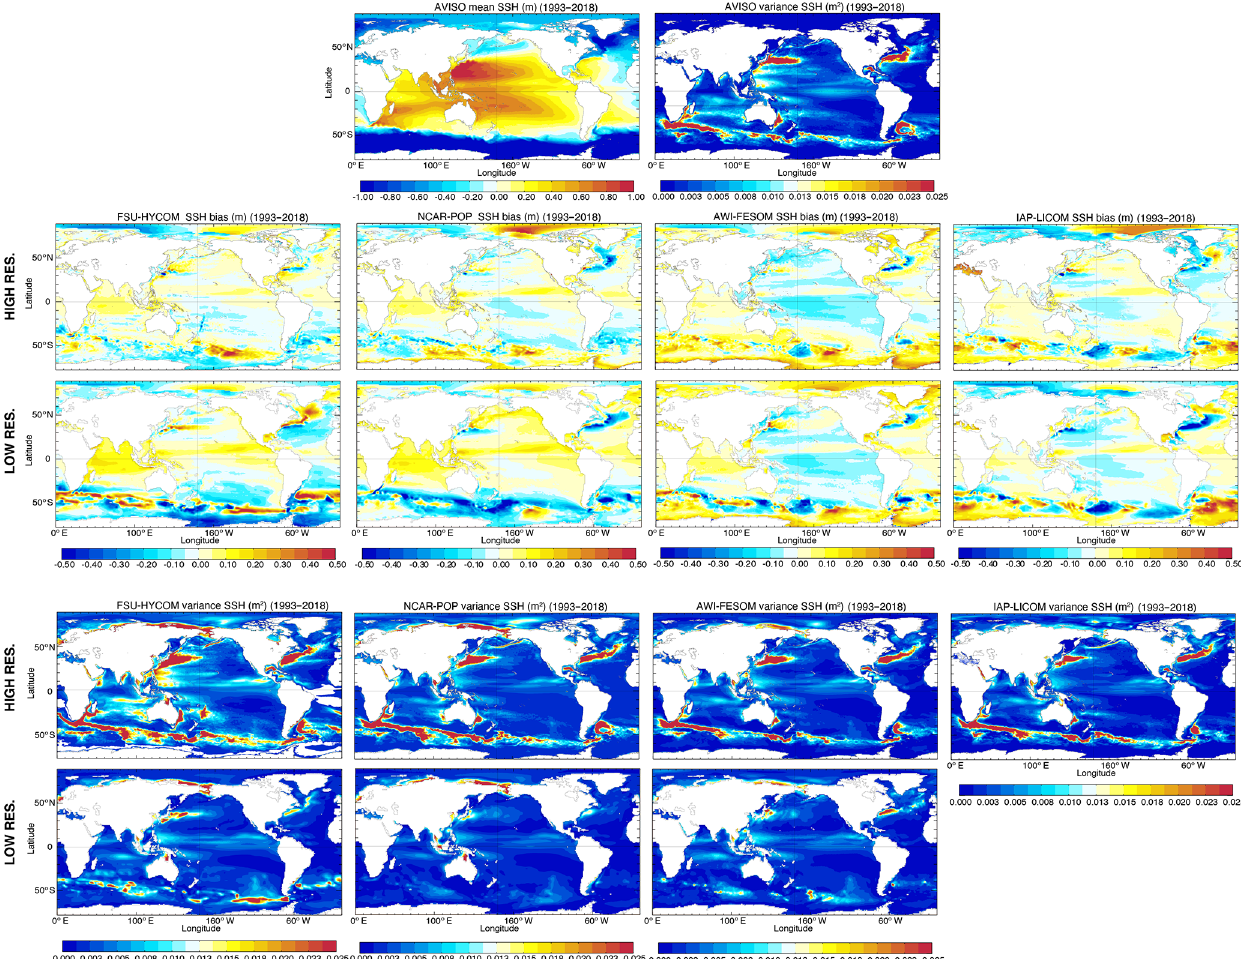
Figure 17. Top panels: mean 1993–2018 SSH and variance AVISO. Middle panels: difference between the mean modeled SSH and AVISO SSH. Bottom panels: modeled variance derived from 5d average outputs. The low-resolution IAP-LICOM SSH variance was not